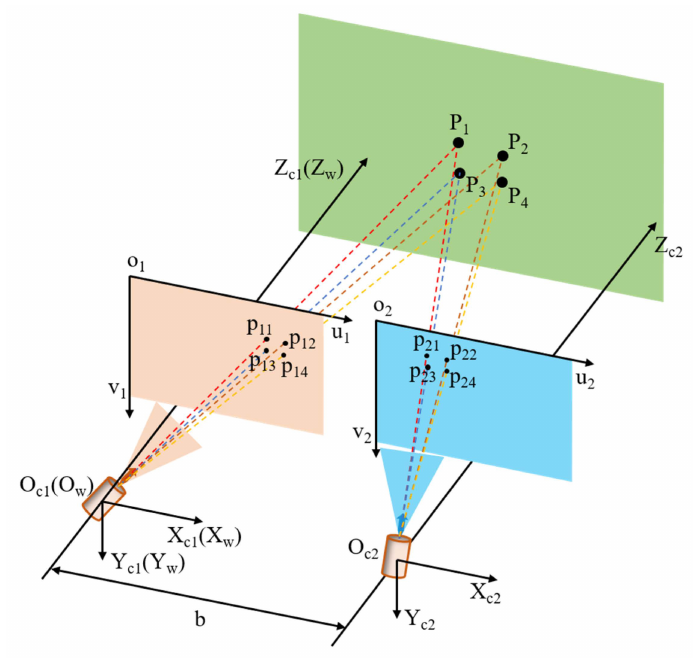
Figure 1. Pose acquisition model based on binocular vision 3D